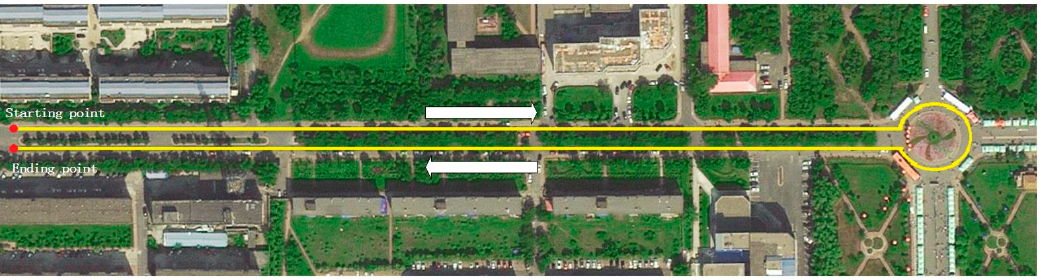
Figure 7. The experimental scenario and route.